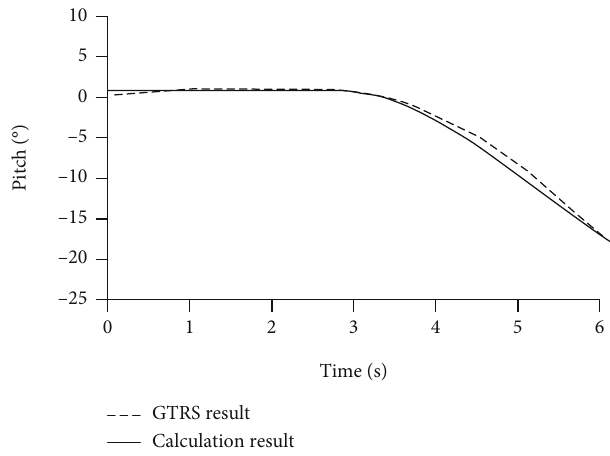
Figure 4: Pitch angle step response in helicopter mode (hover).